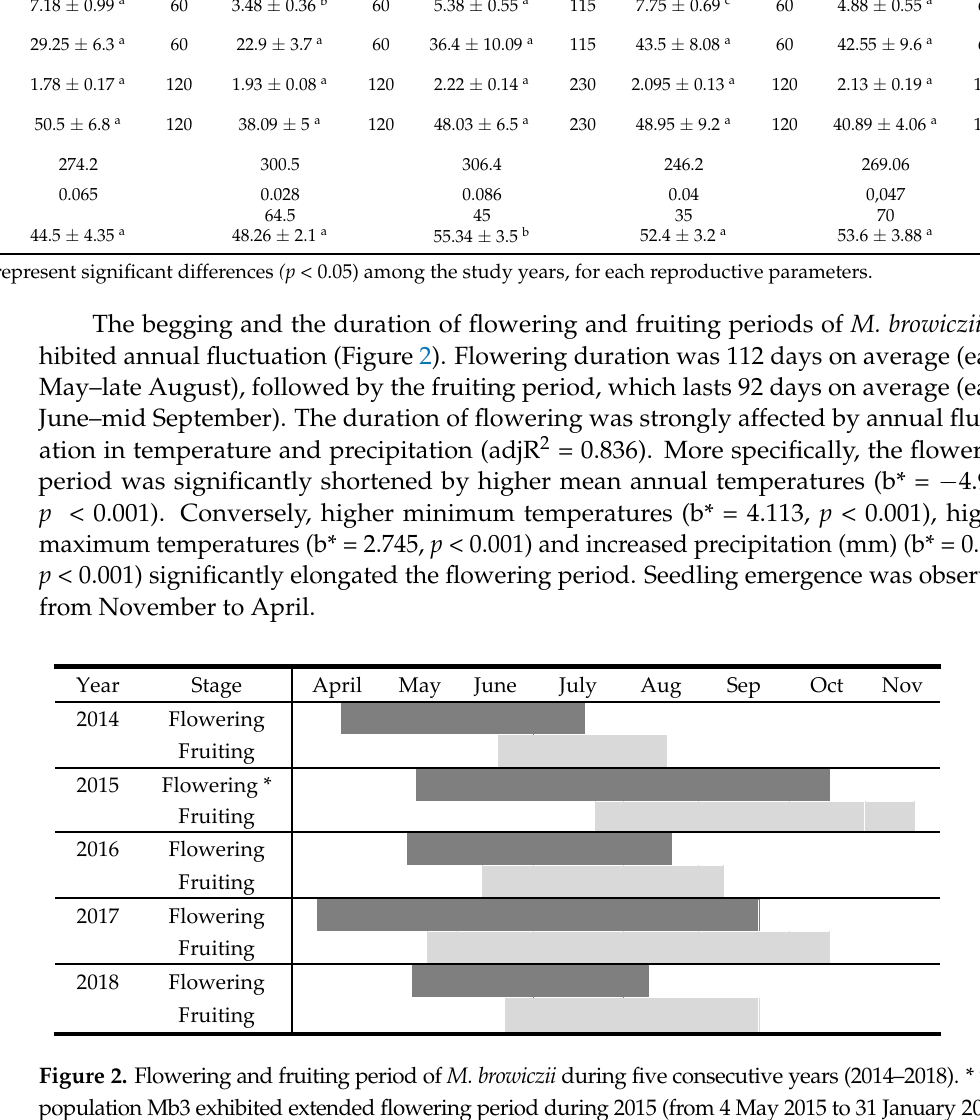
Table 4. Characteristics of reproductive biology and fecundity (expressed as mean number of fruits produced per individual) of M. browiczii during five consecutive years (2014–2018). n = sample size (i.e., number of randomly selected mature individuals or number of stems from tagged individuals).